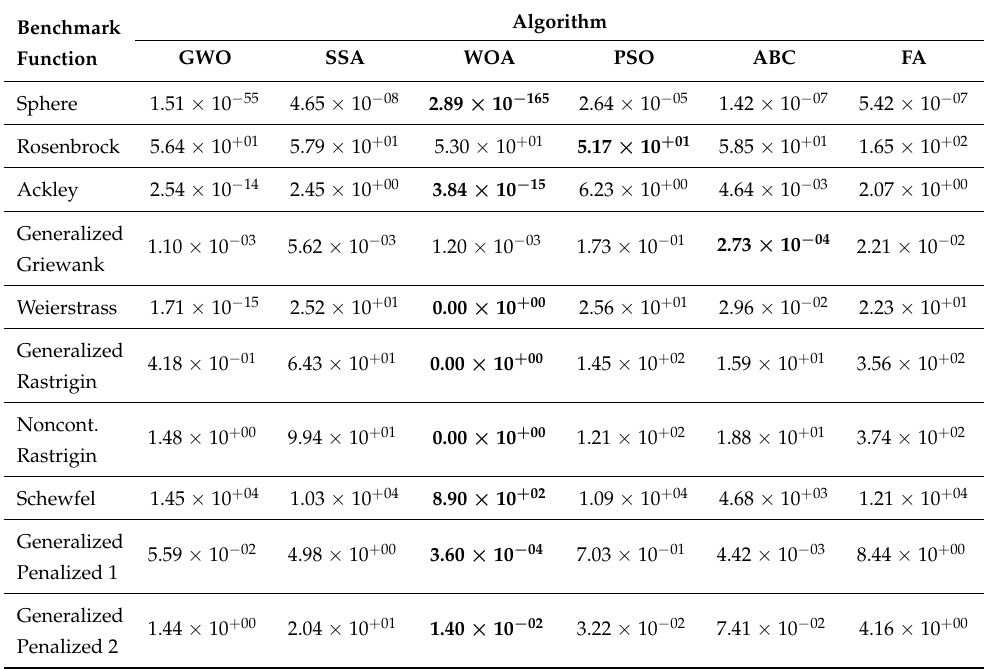
Table 2. Numerical results (average values) of the emerging SI algorithms (GWO, SSA, WOA) and PSO, ABC, FA for several benchmark functions ( D = 60, best values are indicated in